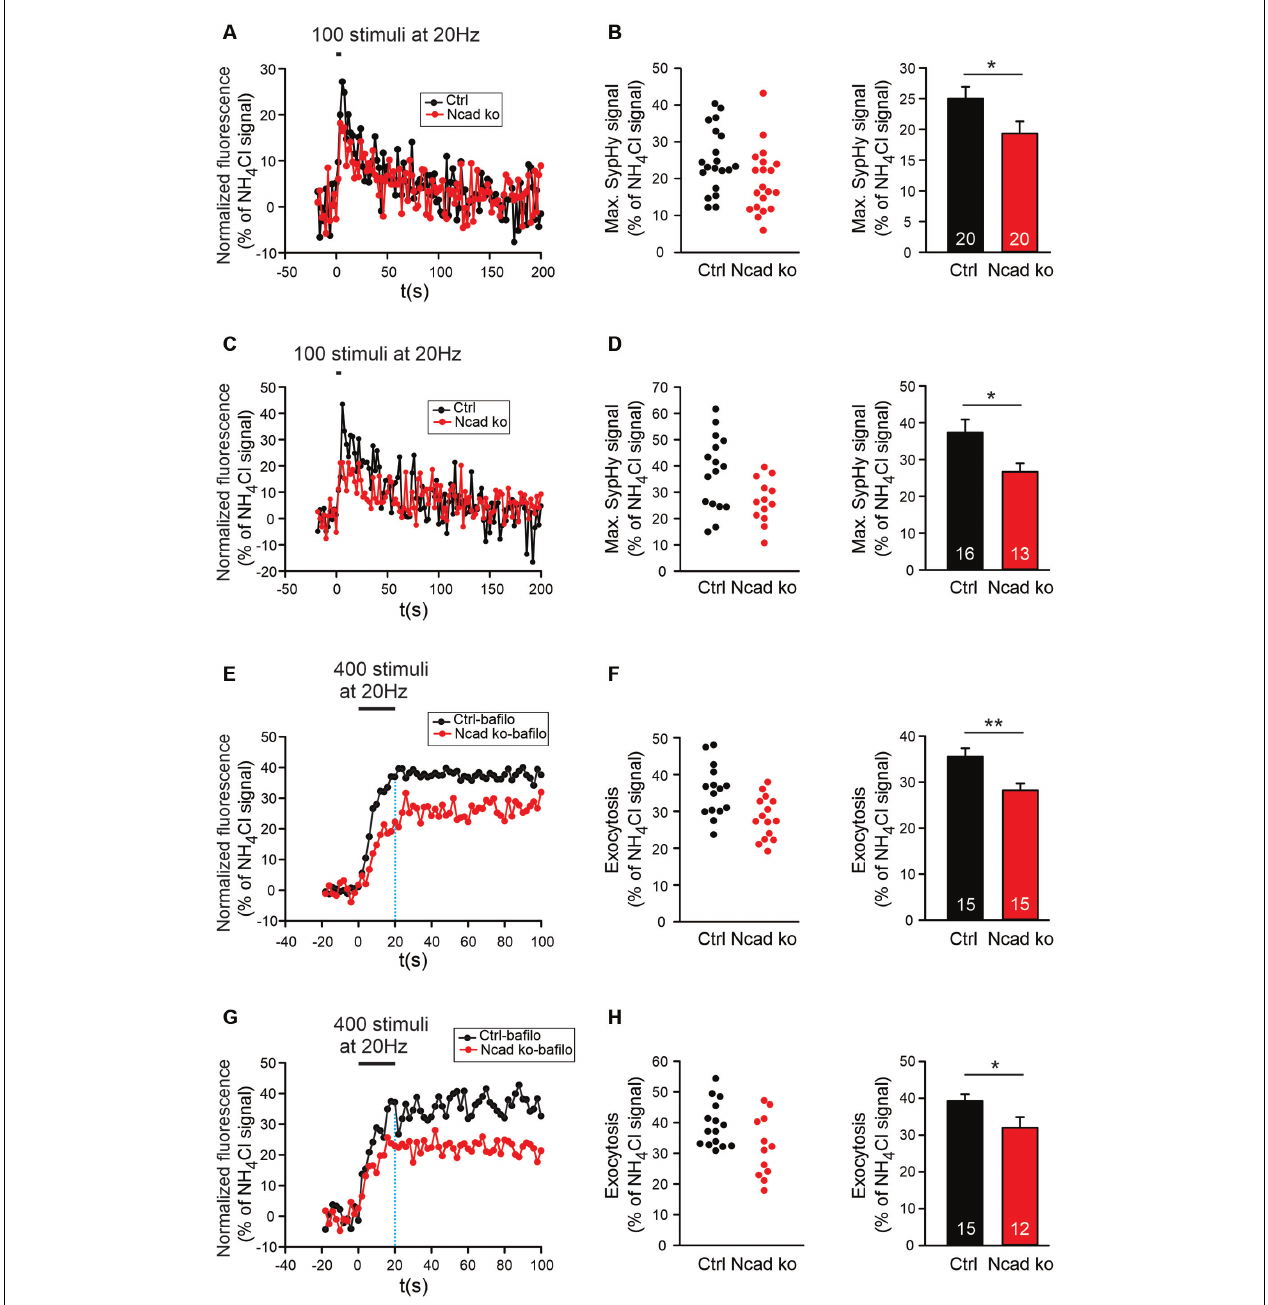
FIGURE 5 | Knockout of N-cadherin resulted in reduced synaptic vesicle exocytosis with short-term stimulation at near physiological temperature (34 ◦ C). (A,B) Effect of N-cadherin knockout on synaptic vesicle exocytosis studied with shortterm stimulation at autapses in cultured cortical neurons. (A) Example time courses of mean SypHy fluorescence intensities (all puncta per cell averaged, normalized to NH 4 Cl signal) for control (co-expressing DsRed2 + SypHy; black) and N-cadherin knockout (co-expressing DsRed2 + SypHy + CreEGFP; red) neurons in response to 100 stimuli at 20 Hz at 34 ◦ C. (B) Quantification of mean SypHy intensities at the end of stimulation (5 s; maximal SypHy signal) in individual neurons ( left ), and means ± SEM ( right ) for control (black) and N-cadherin knockout (red) neurons. n = 20/20 cells, total SypHy puncta analyzed were 333/383. P = 0.047. (C,D) Effect of N-cadherin knockout on synaptic vesicle exocytosis studied with short-term stimulation at axonal release sites. (C) Example time courses of mean SypHy fluorescence intensities (all puncta per cell averaged, normalized to NH 4 Cl signal) for control (black) and N-cadherin knockout (red) neurons in response to 100 stimuli at 20 Hz at 34 ◦ C. (D) Quantification of mean SypHy intensities at the end of stimulation (5 s; maximal SypHy signal) in individual neurons ( left ), and means ± SEM ( right ) for control (black) and N-cadherin knockout (red) neurons. n = 16/13 cells, total SypHy puncta analyzed were 212/130. P = 0.023. The Student’s t -test was used for statistical analysis, * P < 0.05 (B,D) . (E,F) Effect